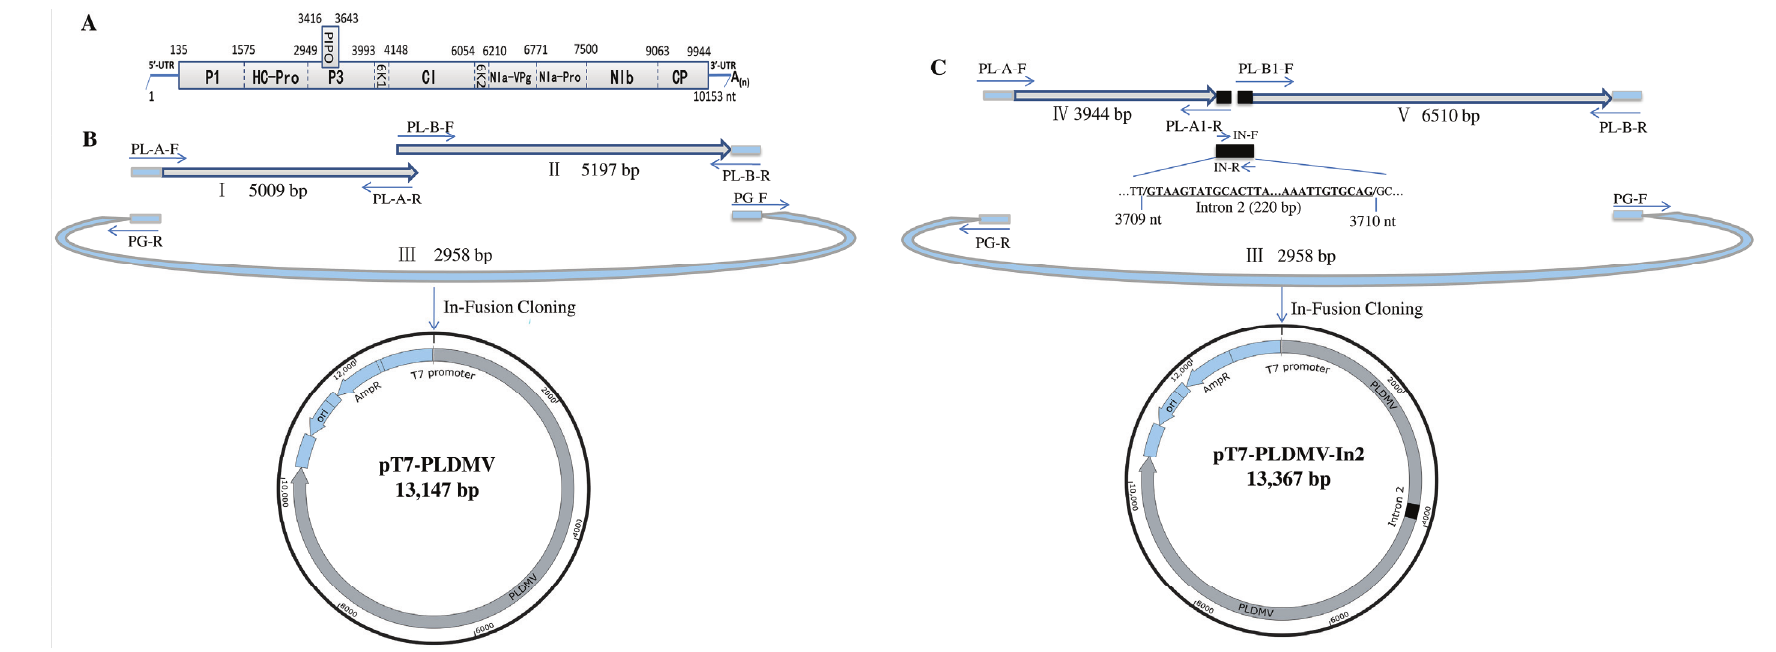
Figure 1. Strategy for constructing intron-less and intron-containing infectious full-length cDNA clone of PLDMV-DF using In-Fusion cloning. ( A ) Schematic representation of the genomic structure of PLDMV; ( B ) Two genomic fragments overlapping the complete genome (fragments I and II) and fragment III of pGEM-T vector containing a T7 promoter were fused to generate the pT7-PLDMV vector by In-Fusion cloning. Arrows indicated the primers used in construction of pT7-PLDMV (Table 1); ( C ) Two genomic fragments overlapping the complete genome (fragments IV and V), the intron 2 (220 bp) of the NiR gene from Phaseolus vulgaris and fragment III of the pGEM-T vector containing a T7 promoter were fused to generate the PLDMV-DF-In2 vector by In-Fusion cloning. Arrows indicated the primers used in construction of PLDMV-DF-In2 (Table 1).